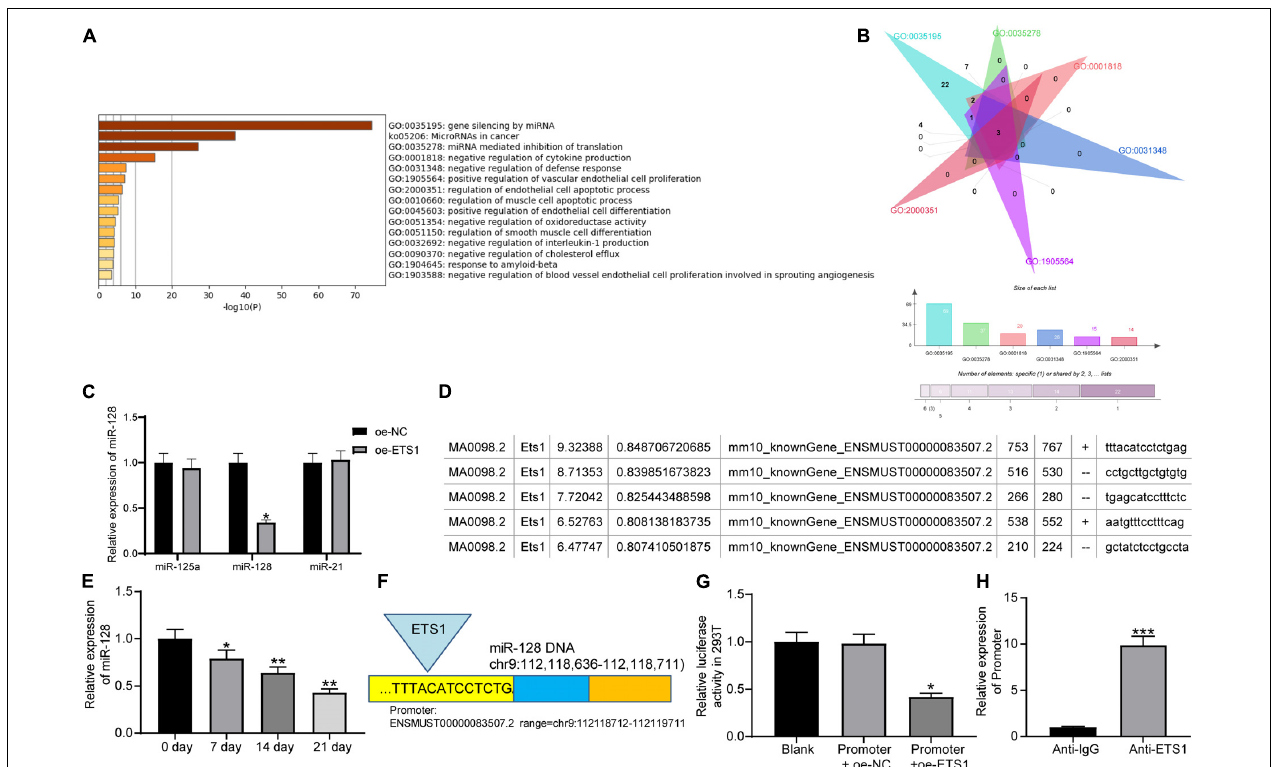
FIGURE 3 | ETS1 transcriptionally suppresses miR-128 expression. (A) Candidate target miRNAs of ETS1 predicted on the hTFtarget system. (B) Common miRNAs enriched on the six most enriched signaling pathways according to the GO enrichment analysis. (C) Expression of miR-125a, miR-128 and miR-21 in MC3T3-E1cells overexpressing ETS1 examined by RT-qPCR (two-way ANOVA, * p < 0.05). (D) Putative binding sequence between ETS1 and miR-128 obtained from the Jaspar system. (E) MiR-128 expression in MC3T3-E1 cells during osteogenic differentiation measured by RT-qPCR (one-way ANOVA, * p < 0.05; ** p < 0.01, compared to day 0). (F) The Promoter sequence of miR-128 selected for luciferase assay. (G) Binding relationship between ETS1 and miR-128 promoter determined by luciferase assay (one-way ANOVA, compared to Promoter + oe-NC, * p < 0.05). (H) Promoter enrichment in the precipitate compound pulled down by anti-ETS1 (unpaired t -test, *** p <